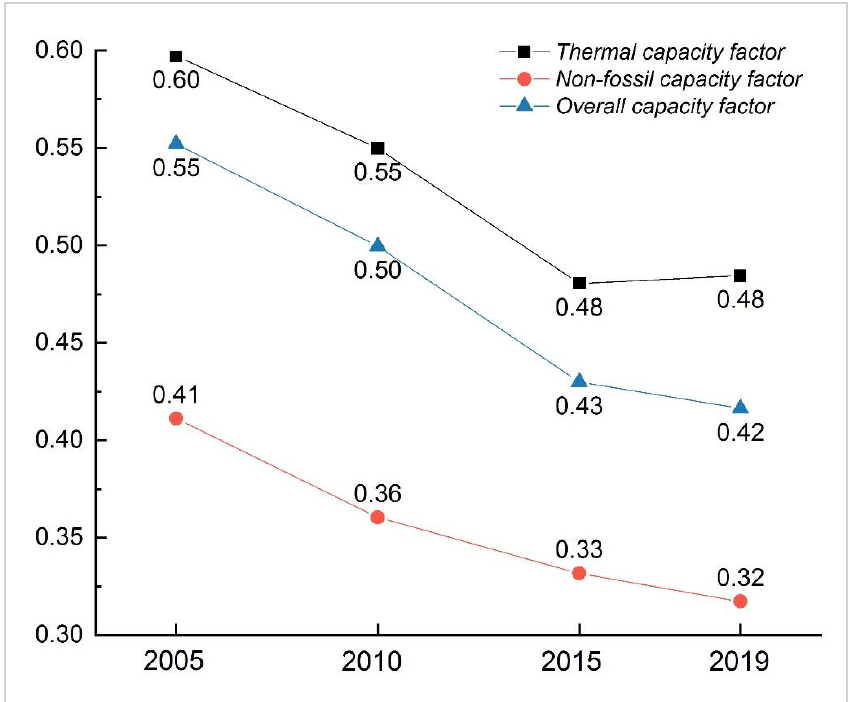
Figure 4. The change in China’s capacity factors.